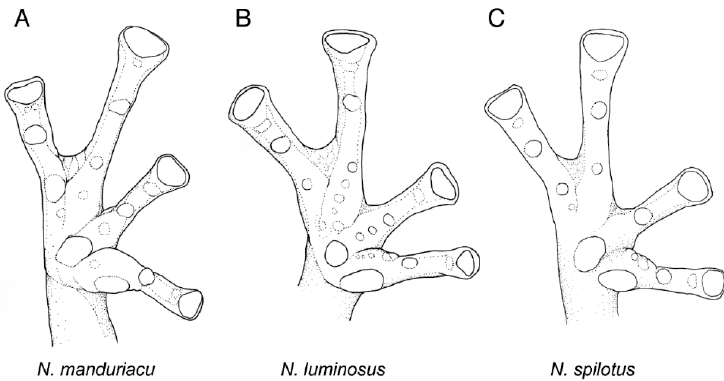
melanophores concentrated around yellow spots, sometimes looking like false ocelli. Upper lip unpigmented. Inner fingers and toes with yellowish hue. Anterior half of ventral parietal peritoneum white, posterior portion translucent. Green bones. Iris light grey with thin, dark grey reticulations and pale-yellow hue around pupil